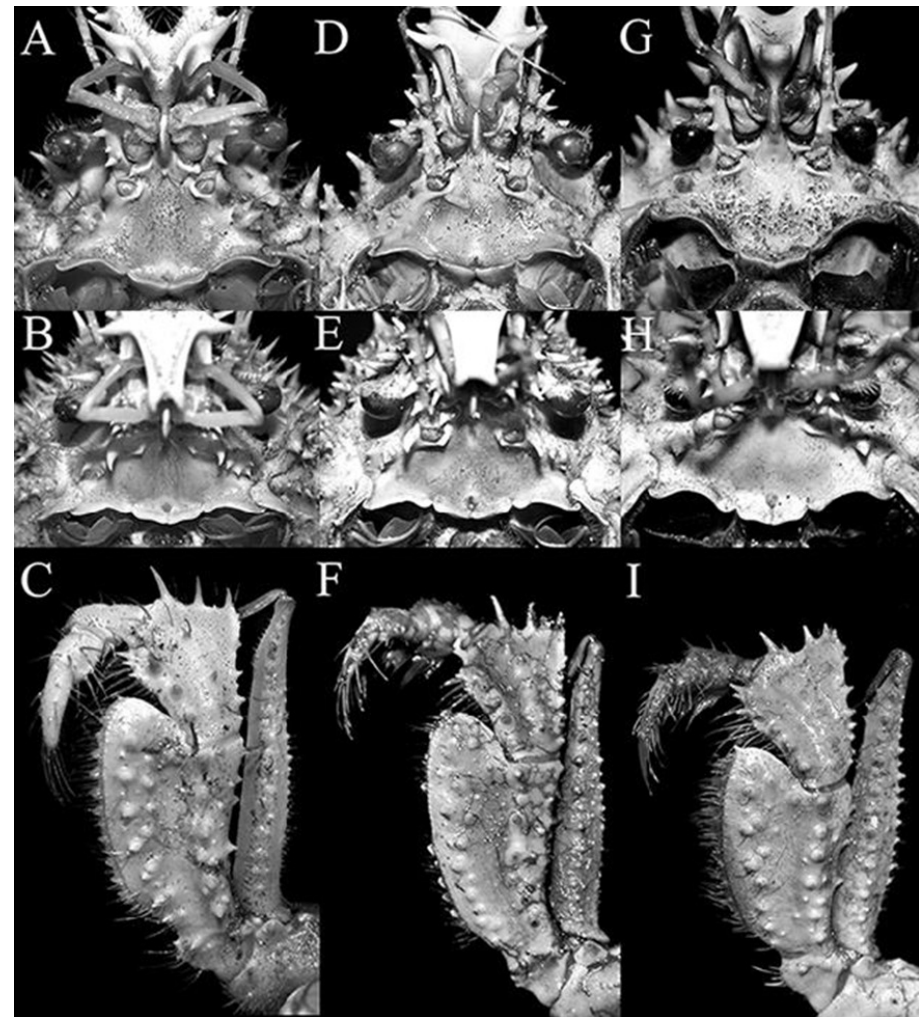
Figure 7. A–C Pleistacantha moseleyi (Miers, 1885), male (cl 82.5 mm, cw 61.6 mm) (ZRC 2005.117), Philippines D–F Pleistacantha pungens (Wood-Mason, in Wood-Mason & Alcock, 1891), male (cl 94.0 mm, cw 67.6 mm) (ZRC 2016.23), Myanmar G–I Pleistacantha kannu sp. n., holotype male (cl 106.2 mm, cw 87.0 mm) (CASAU), India. A , D , G epistome, antennae and antennules; B, E, H epistome; C, F, I left third